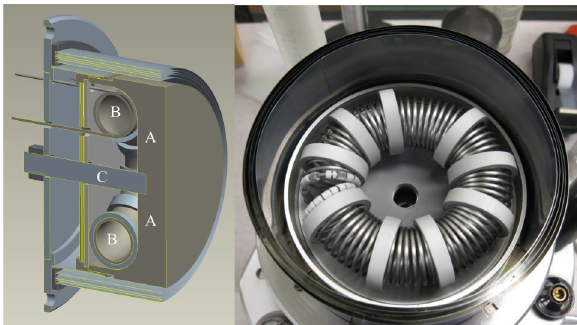
FIG. 3. Left: CAD model of the 10.9-cm diameter emitter, heating filament, and heat shield. The filament is region B, and the central support rod is marked C . Right: The filament is shown, before installation in the source. The tungsten filament, 1.52-mm diameter, is electrically isolated from the heat-shield assembly by boron nitride hoops. Smaller boron nitride beads isolate the filament leads where they exit the heat-shield assem- bly for contact with the leads from the filament power